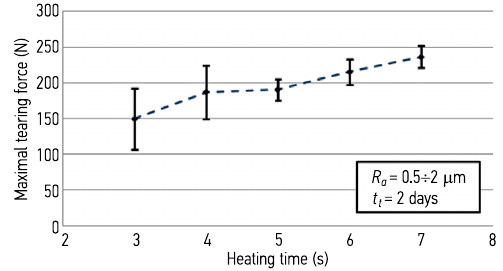
Fig. 9. Effect of heating time on maximal tear force (source: own measurement)